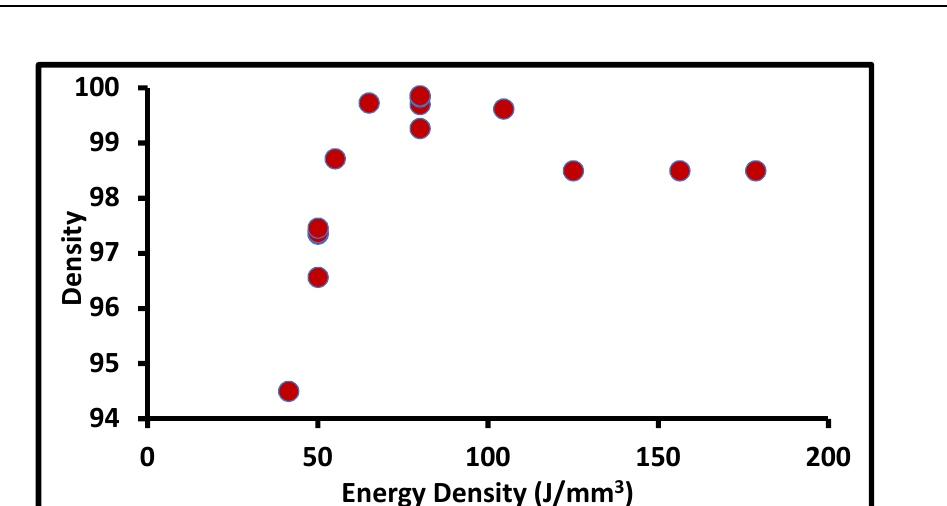
Figure 10. Porosity at different energy densities of 41.81, 104.52, and 209.03 J/mm 3 .